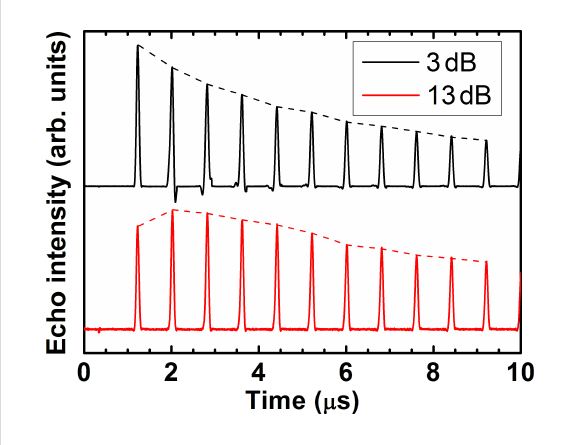
Figure 8: CPMG echoes for complex P1 for two levels of the micro- wave power attenuation of 3 dB and 13 dB. Note that in the latter case the 2nd and not the 1st echo has the strongest amplitude.